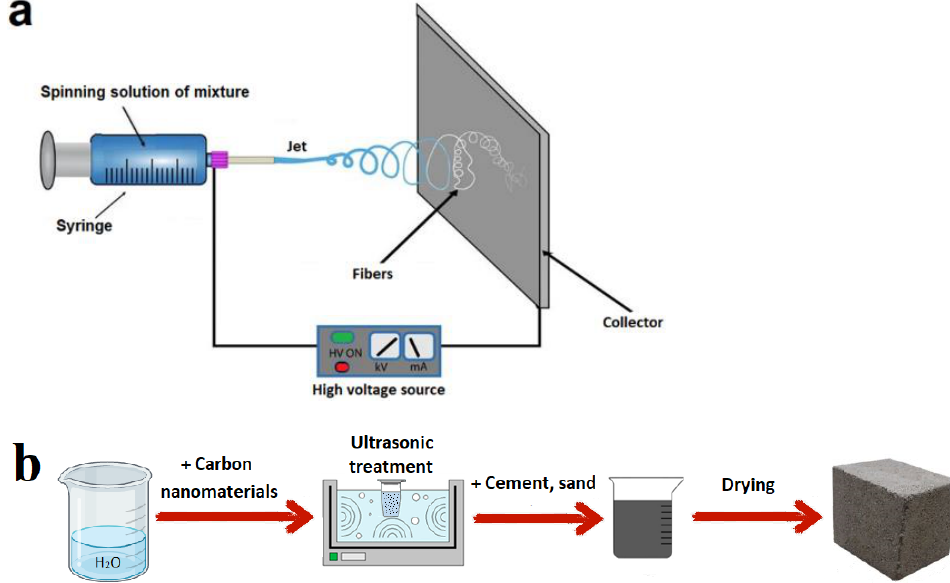
Figure 1. ( a ) Scheme of electrospinning setup with a needle and flat horizontal metal collector, and ( b ) preparation of concrete samples modified with the carbonaceous additive.